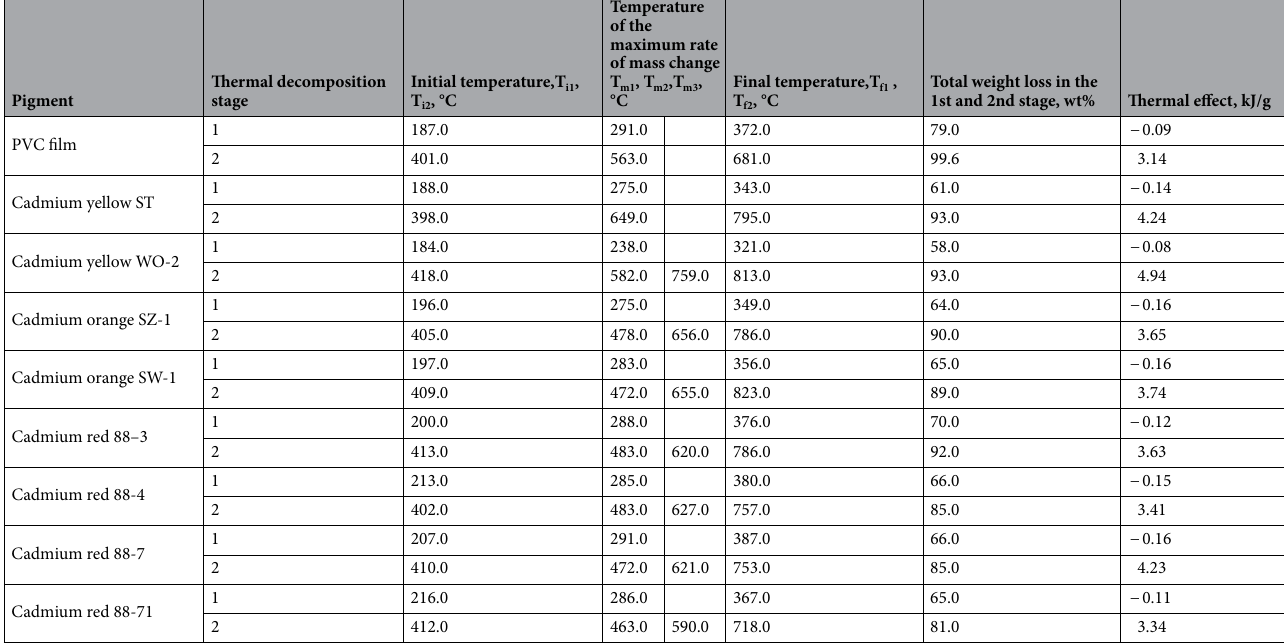
Table 5. PVC membranes with cadmium pigments after UV irradiation.